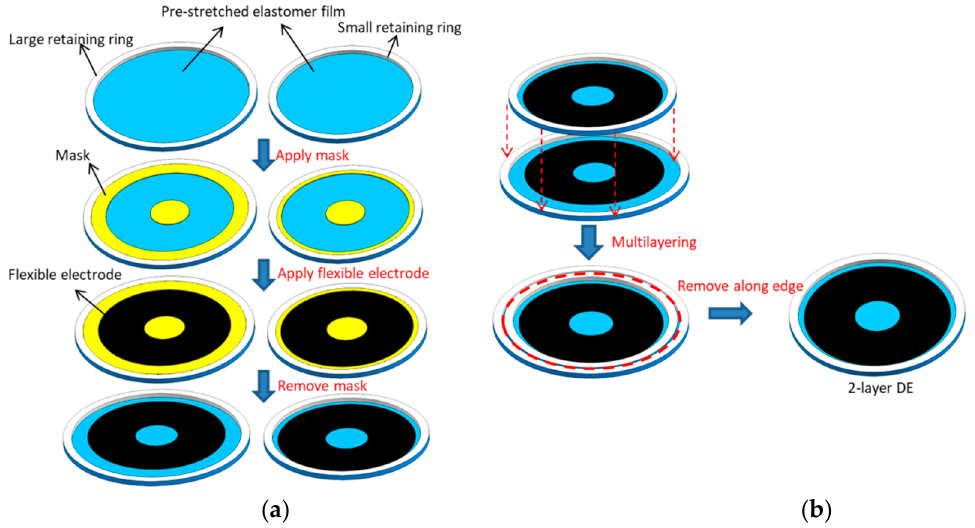
Figure 8. ( a ) The fabrication of single-layer DE. ( b ) The stacking of multilayer DE.